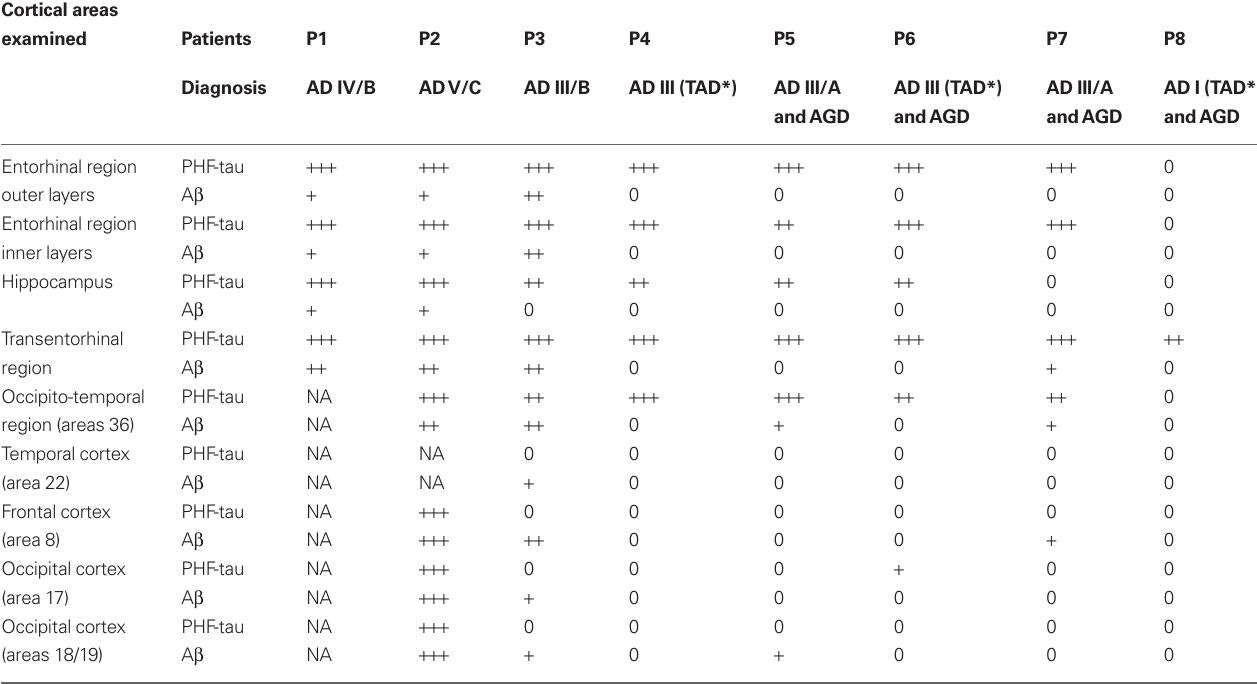
Table 2 | Neuropathological assessment of the accumulation of NFT (immunostained for PHF-tau) and plaques (immunostained for A β ). The overall amount of NFT and A β is graded and labeled zero (0) where no discernible change is detected, ( + ) with a small, ( ++ ) moderate and ( +++ ) large amount of NFT or A β